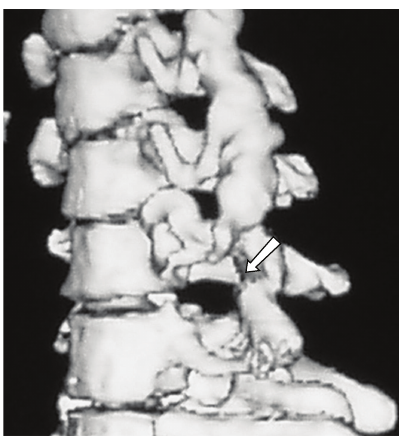
Figure 3: Digital Subtraction Angiography; arrow points the